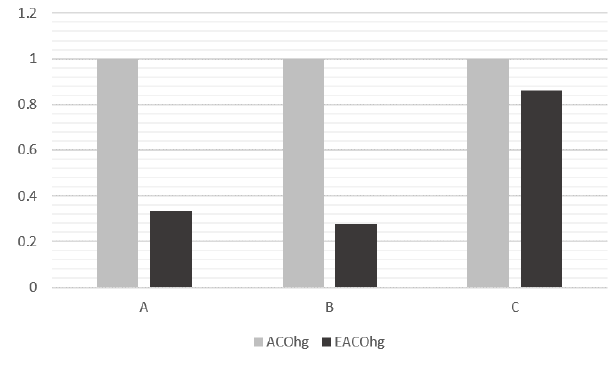
Figure 10. The length of counter examples